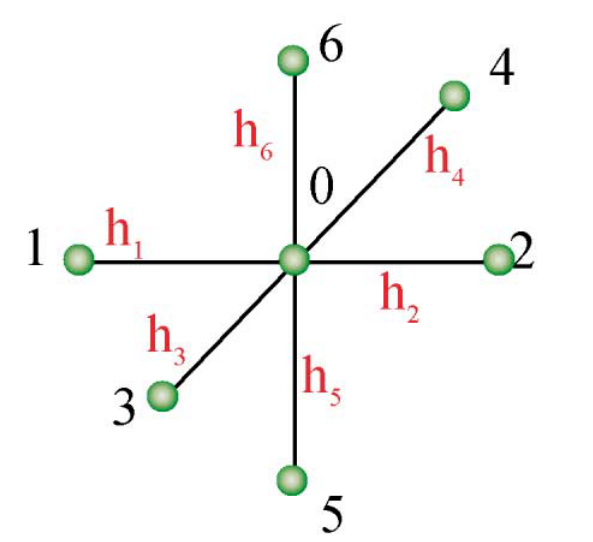
FIG. 1. (Color) Illustration of the finite difference method.